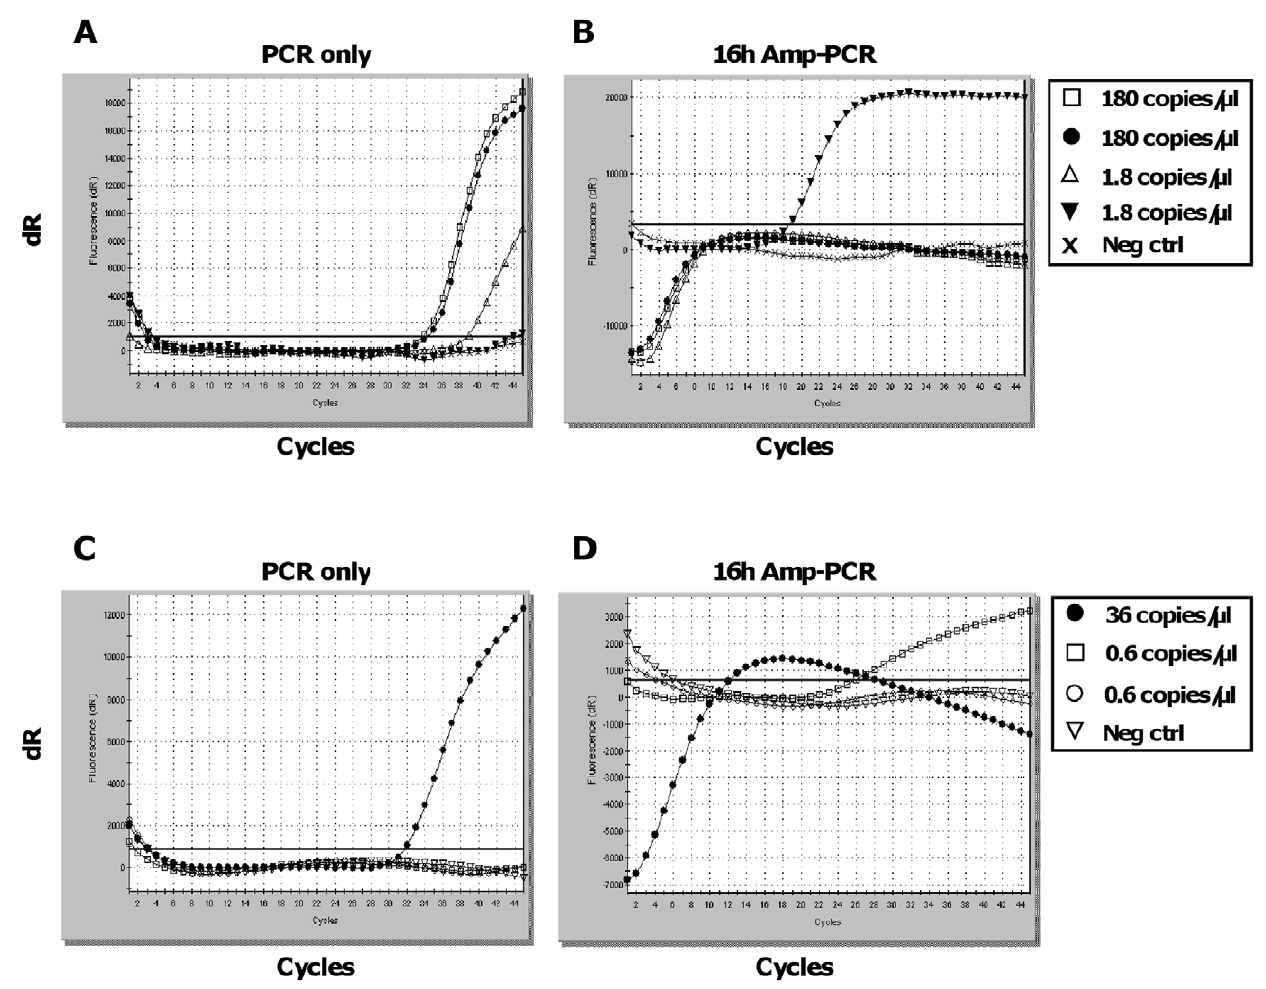
Figure 3. Sensitivity of the Amp-PCR method. To test the sensitivity of 16 hours Amp-PCR, we used two JCV-standard solutions (containing 180 and 1.8 copies/ m l, respectively) and two dilutions of a JCV DNA from a clinical sample (containing 36 and 0.6 copies/ m l, respectively). Sixteen hours of Repli-g reaction was followed by a JCV-specific real-time PCR reaction. (A) PCR only on duplicate samples of 180 and 1.8 copies/ m l JCV-standards. Negative control for the PCR is water. (B) Amp-PCR on duplicate samples of 180 and 1.8 copies/ m l JCV-standards (showing typical wave-shaped curves reported for over-saturated PCR-reactions). Negative control for the amplification is water. (C) PCR only on two diluted JCV DNA samples, containing 36 copies/ m l and 0.6 copies/ m l, respectively. Negative control for the PCR is water. (D) Amp-PCR on two diluted JCV DNA samples, containing 36 copies/ m l (showing a typical wave-shaped curve reported for over-saturated PCR-reactions) and 0.6 copies/ m l, respectively. Negative control for the amplification is water.